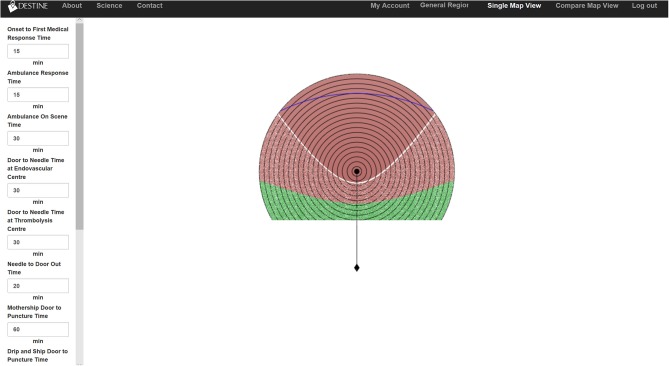
Two-dimensional temporospatial diagrams from the DESTINE software (v0.01), which was used in the usability tests. The user data entry panel is shown on the left-hand side. The top bar contains clickable items allowing the user to select the region of interest as well as convert from single view to the compare view. The resultant temporospatial visualization is displayed in the middle of the screen. In the visualizations the thrombolysis center is represented by a black dot and the EVT center is represented by a black diamond below it. The travel time between the two centers is represented by the vertical line connecting them. The thrombolysis center is surrounded by concentric circles representing 5-min increments of travel time. The concentric circles only extend to the half-way point between the two centers as below this point the EVT center is the closest hospital to the patient and decision making would not be needed. The diagram is color coded such that areas in red indicate that drip-and-ship predicts best patient outcomes, areas in green indicate mothership predicts best outcomes and areas overlaid with white stippling indicate the difference in probability of good outcome between the two options is minimal (<0.01).